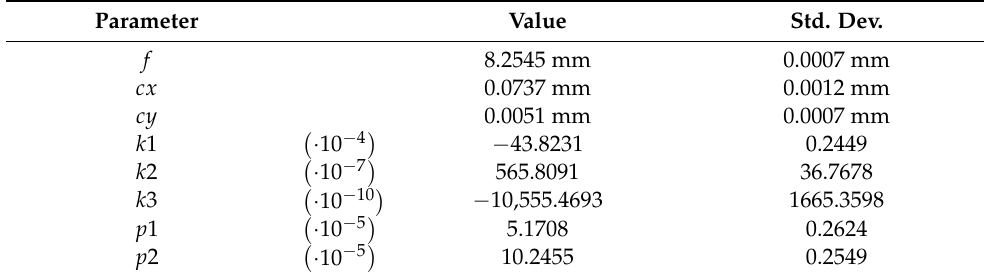
Table 4. Parameters of the interior orientation after calibration using the 3D calibration test-field.